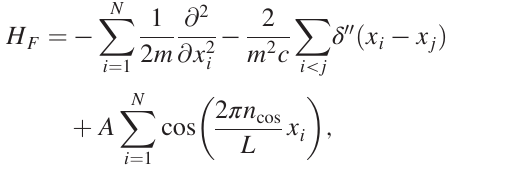
P N Q ˆ Q a 2 m 2 m , m ¼ 1